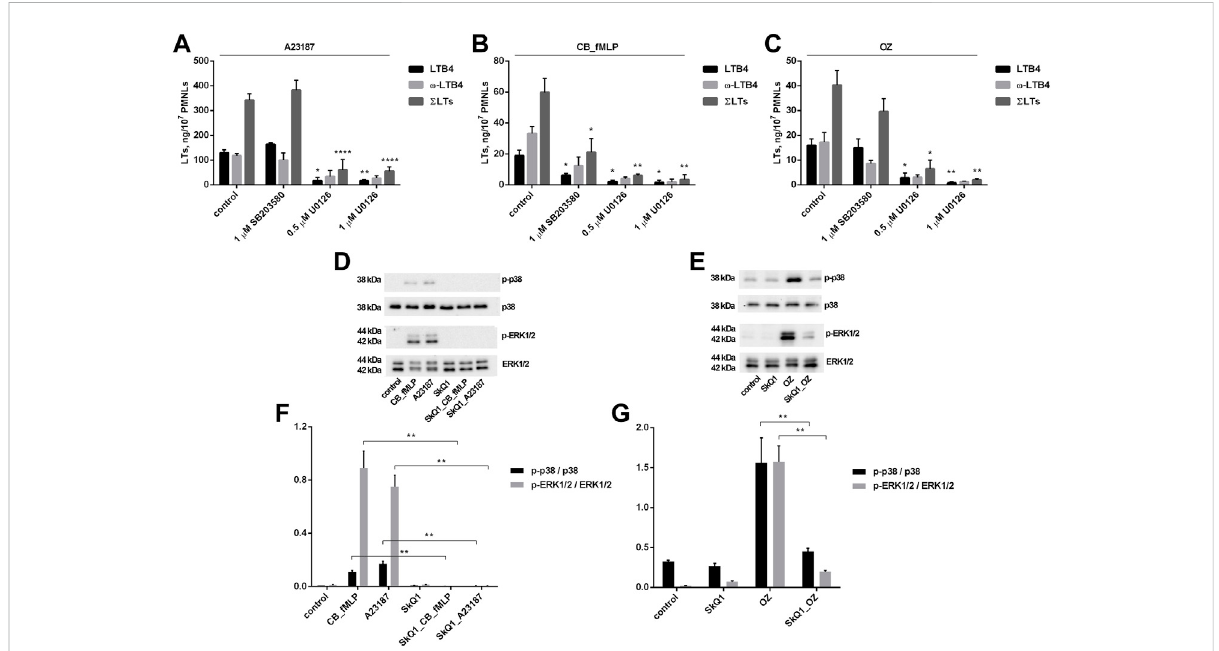
FIGURE 3 Effect of p38 inhibitor SB203580 and ERK1/2 inhibitor U0126 on leukotriene synthesis in human neutrophils (A – C) and effect of SkQ1 on p38 and ERK1/2 phosphorylation (D – G) . Before treatment, PMNLs [(1 – 1.2) × 10 7 /6 ml at (A – C) ; 3 ml × 10 5 /0.3 ml at (D – G) ] were pre-incubated for 10 min at 37 ° C at CO 2 incubator. Then cells were treated 30 min with reagents indicated on X -axis (A – C) or with 100 nM SkQ1 (d,e,f,g, where indicated).Afterthat,1 µMA23187(for10 min)or,sequentially,5 µMcytochalasinB(for10 min)and0.1 µMfMLP(for10 min)or0.04 mg/mlOZ (for 10 min), were added, as indicated. (A – C) The 5-LOX products were analyzed using HPLC, and data for LTB4, ω -OH-LTB4 and the sum of leukotrienes ( Σ LTs = LTB4 + trans-LTB4 + ω -OH-LTB4) are presented. Values present mean ± SEM of three independent experiments performed in duplicate. * p < 0.05, ** p < 0.01, **** p < 0.0001 for pairs of data (marked column compared with corresponding control value) by two-way ANOVA followed by Tukey ’ s multiple comparison test. (D – G) PMNLs lysates were separated onto 12% SDS polyacrylamide gels, then blotted to PVDF membranes and probed with antibodies against p-38, phospho-p38, ERK1/2, phospho-ERK1/2 as described in Methods. Representative Western blots are shown (D,E) . The ratios of phospho-p38 to p38 and phospho-ERK1/2 to ERK1/2 (F,G) are plotted as means ± SEM of three independent experiments, ** p < 0.01 for pairs of data indicated by brackets.